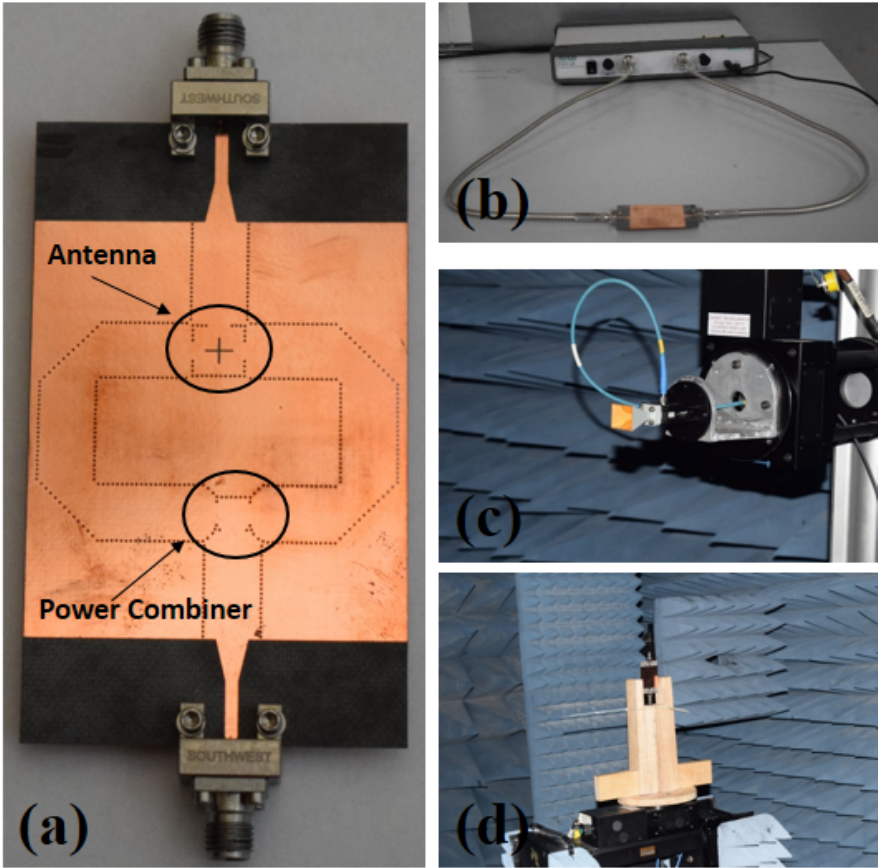
Figure 10. ( a ) SIW antenna system, ( b ) SIW antenna system with VNA, ( c ) standard gain antenna, ( d ) SIW antenna system in anechoic chamber.